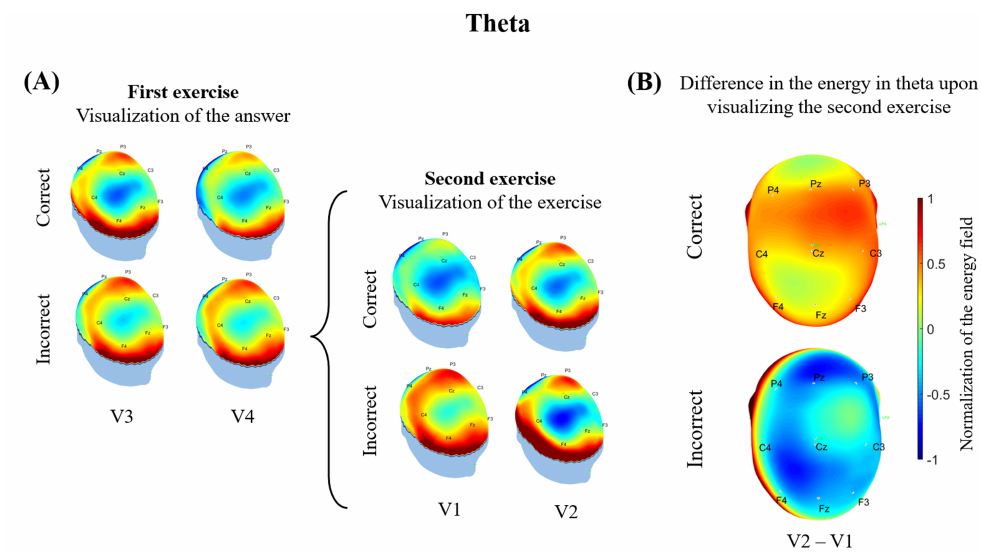
Figure 9. Relative energy of the theta band. EEG activity of the theta band in the central region. ( A ) representation of theta brain activity at the time of visualizing (i) the first correct vs. incorrect response, and (ii) the second response after the incorrect response; ( B ) representation of the difference in V2–V1 theta brain activity, where a positive change in energy is observed in the visualization of the second question, when she/he answered correctly (at this moment, she/he does not know if the answer is correct), while on the contrary, there is a negative change in energy at the moment of visualizing the second question when she/he answered